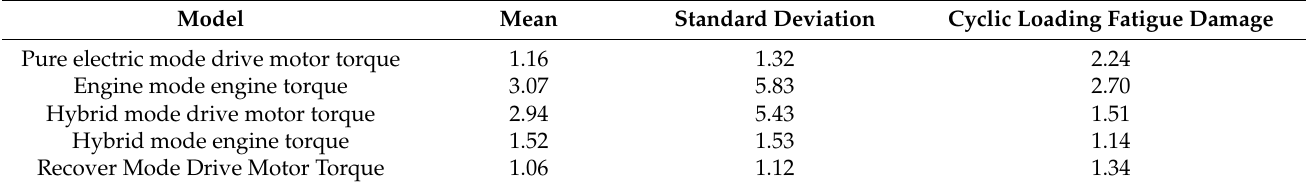
Table 2. The optimal number of samples for urban working conditions determined by each criterion.